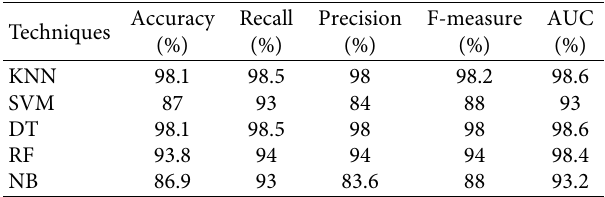
Table 7: Classification performance of applying the bagging technique to selected features by LDA.